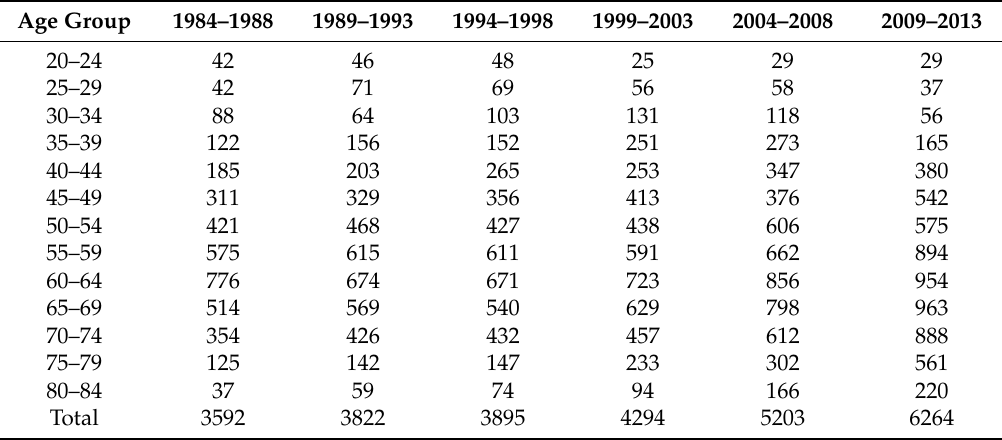
Table A2. Age-specific cancer deaths during 1984–2013 in Macheng